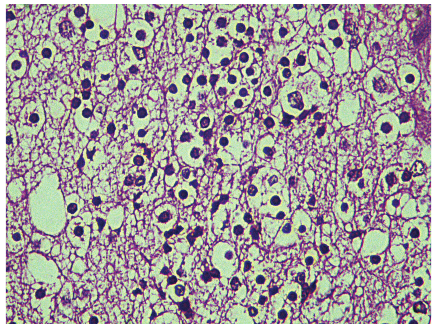
Figure 3: “Fried-egg” appearance of oligodendroglioma.